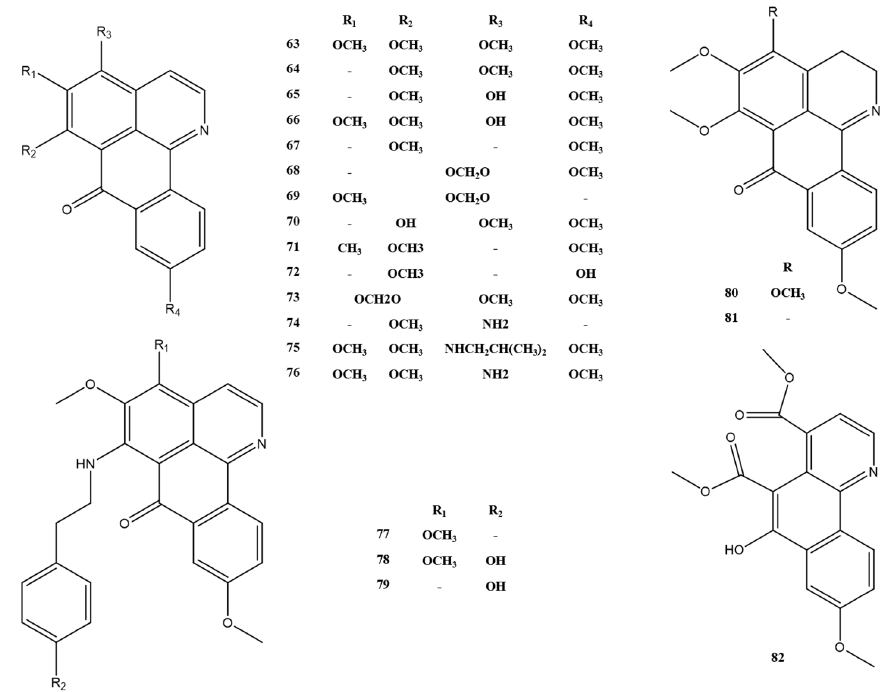
Figure 6. Oxidized isoporphine alkaloids in M. Rhizoma.